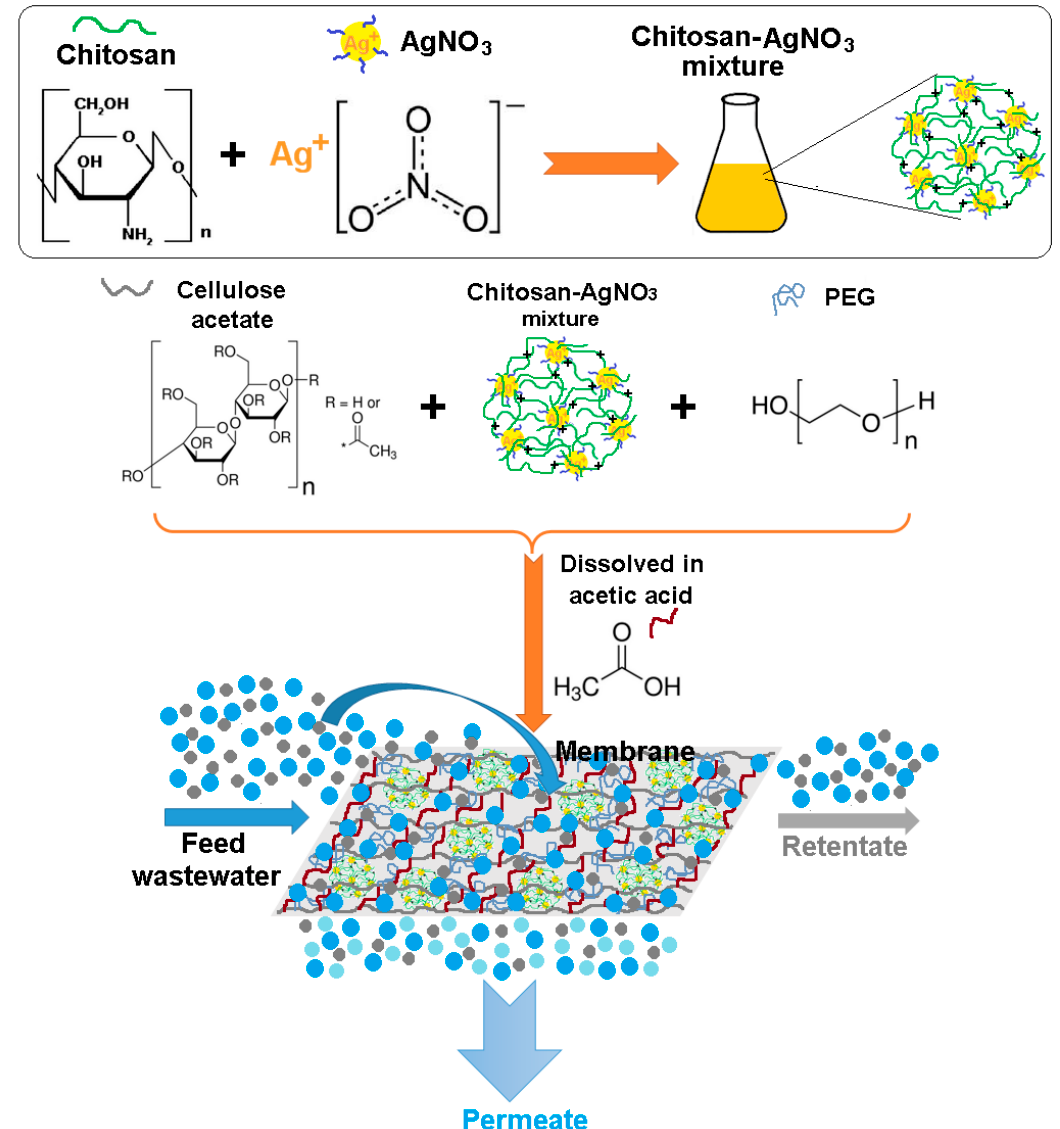
Figure 1. Schematic illustration mechanisms for the obtaining of the biopolymeric membrane for removal of metal ions by electrodialysis process.